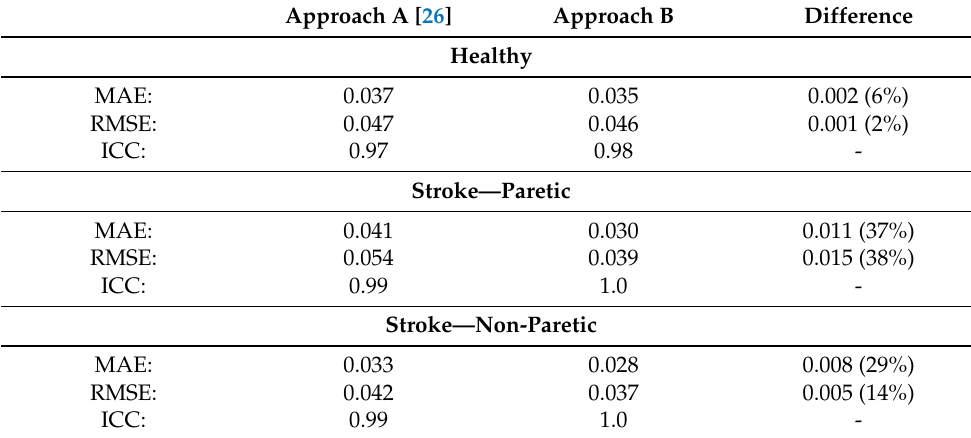
Table A1. Walking speed estimation